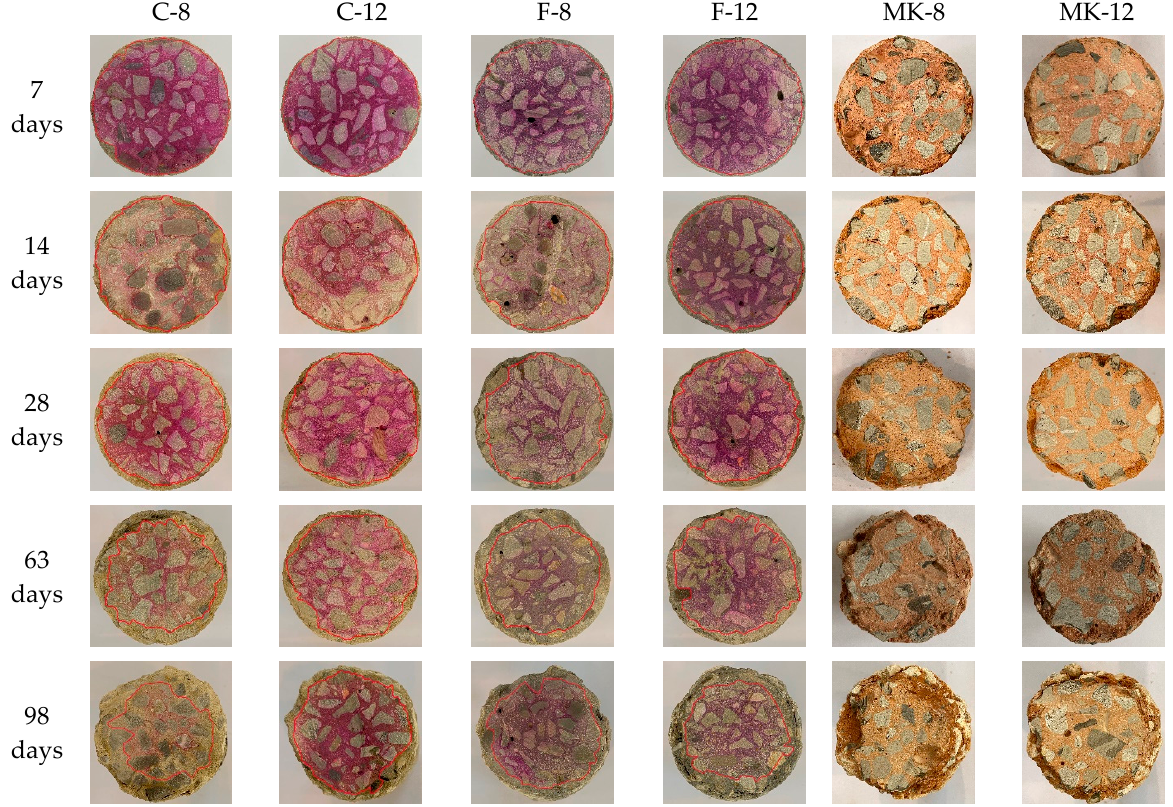
Figure 3. Neutralization depths of GPC.